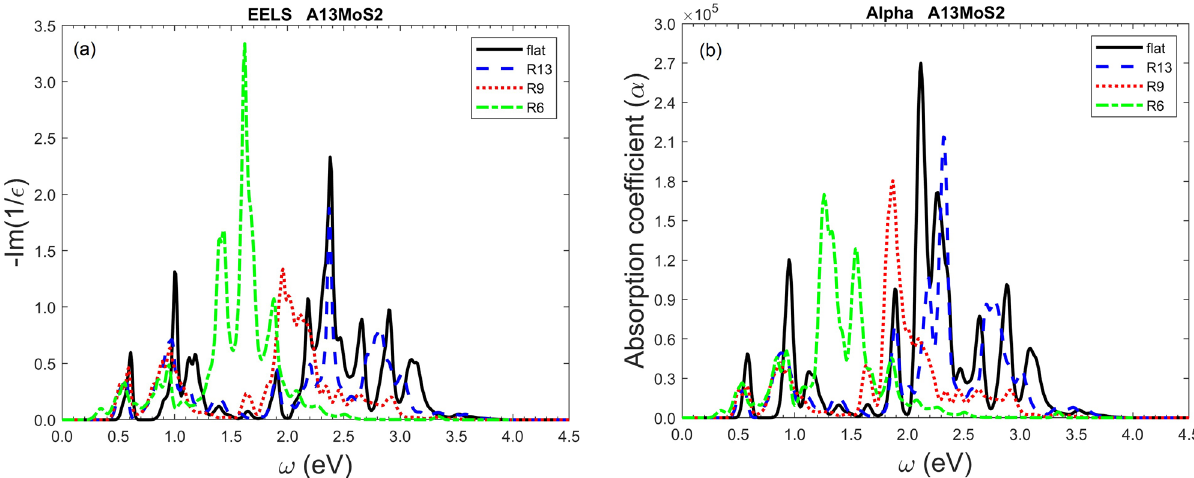
Figure 8. The electron energy loss spectrum (EELS) in ( a ) and absorption coefficient in ( b ) of A13MoS 2 nanoribbon under different bending curvatures. EELS is calculated as the imaginary part of − 1 /(ε 1 + i ε 2 ) . The absorption coefficient α is calculated as ωε 2 /( nc ) (cm −1 , Gaussian unit), where n = (cid:31) ( (cid:30) ε 2 1 + ε 2 2 + ε 1 )/ 2 is the refractive index and c is the speed of light in vacuum. R13 represents the bending curvature radius R = 13 Å and so on. The plots for the A12Mos 2 nanoribbon are in Fig. S24 (Supporting